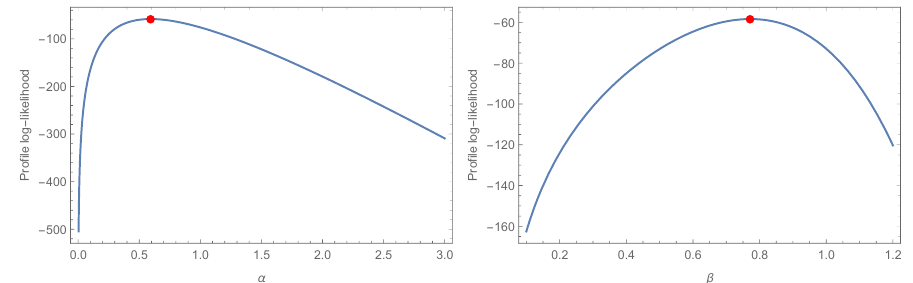
Figure 4. TTT plot (left) and fitted HRF (right) of the PHD model for the COVID-19 dataset.